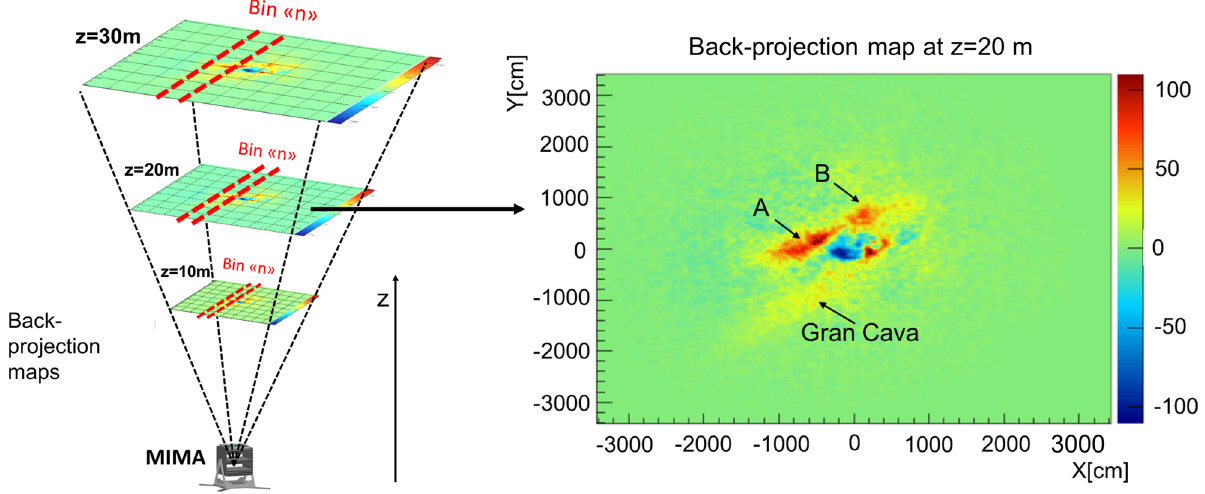
Figure 8. On the left a schematization of the principle used to realized the back-projection maps for different z . On the right an example of back-projection map at z = 20 m (the meaning of the color scale is explained in the text). Three signals are visible: Gran Cava, signal A and B, already observed in the density map. The map is obtained with the ROOT framework.